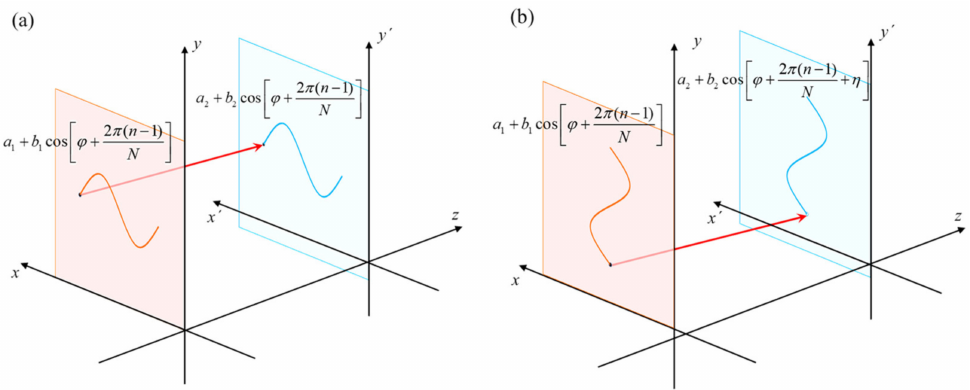
Figure 3. Incoherent superposition of upper and lower surfaces. ( a ) Superposition of sinusoidal fringes in x direction; ( b ) superposition of sinusoidal fringes in y